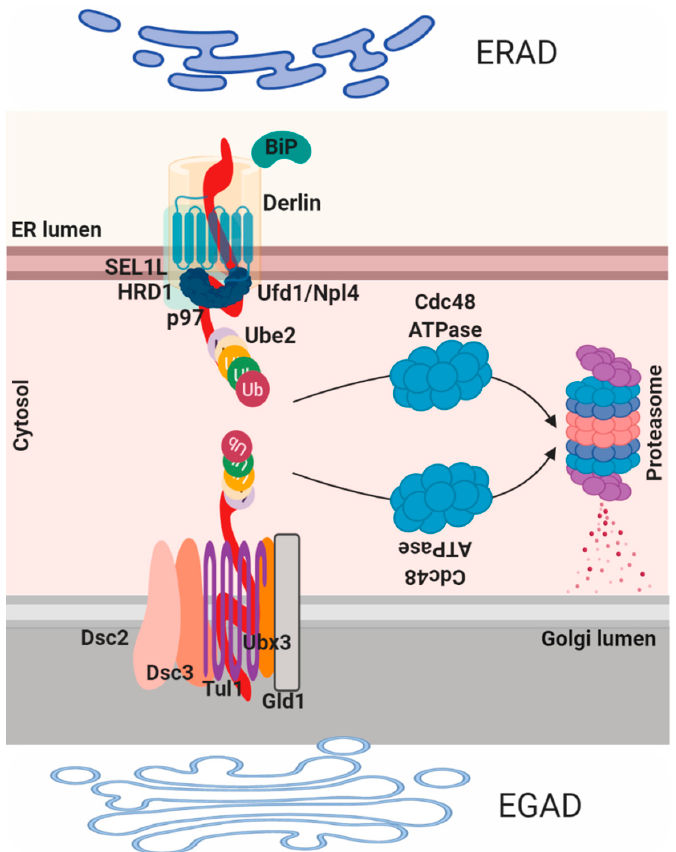
Figure 3. ER and Golgi degradation pathways, namely ERAD (upper panel) and endosome and